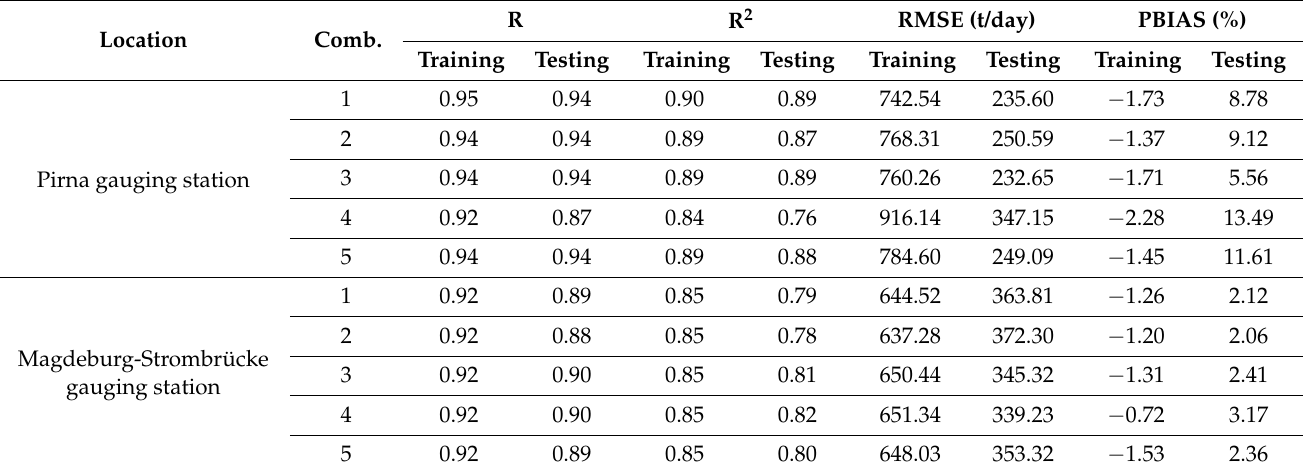
Figure 9. Selection of NN value for combination 1 of the Pirna Station. Table 6. The performance evaluation of the different LLR models.